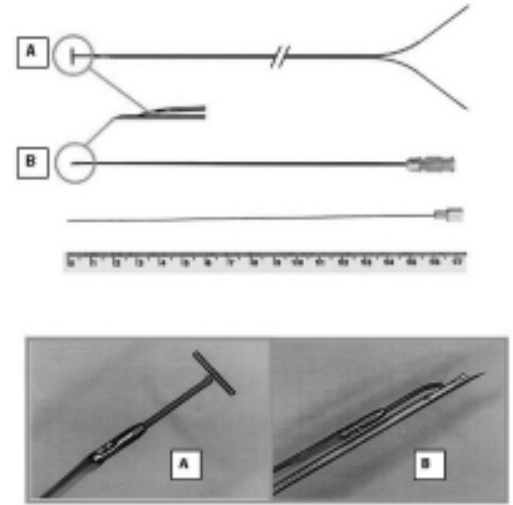
Fig. 1 - Protótipo da agulha com o eletrodo de barra em "T": (A) barra metálica com 4,0 x 0,4 mm; (B) agulha 20-G, modificada na extremidade distal, através de um chanfrado de 25º e extensão de 5,0 mm. Abaixo, o mandril para liberação do